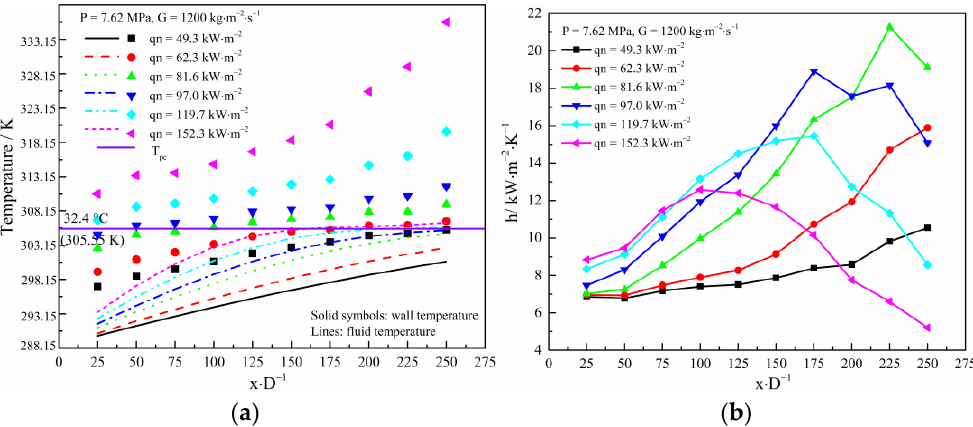
Figure 9. Variation of wall temperature ( a ) and heat transfer coefficient ( b ) along the heating length under different heat flux values.